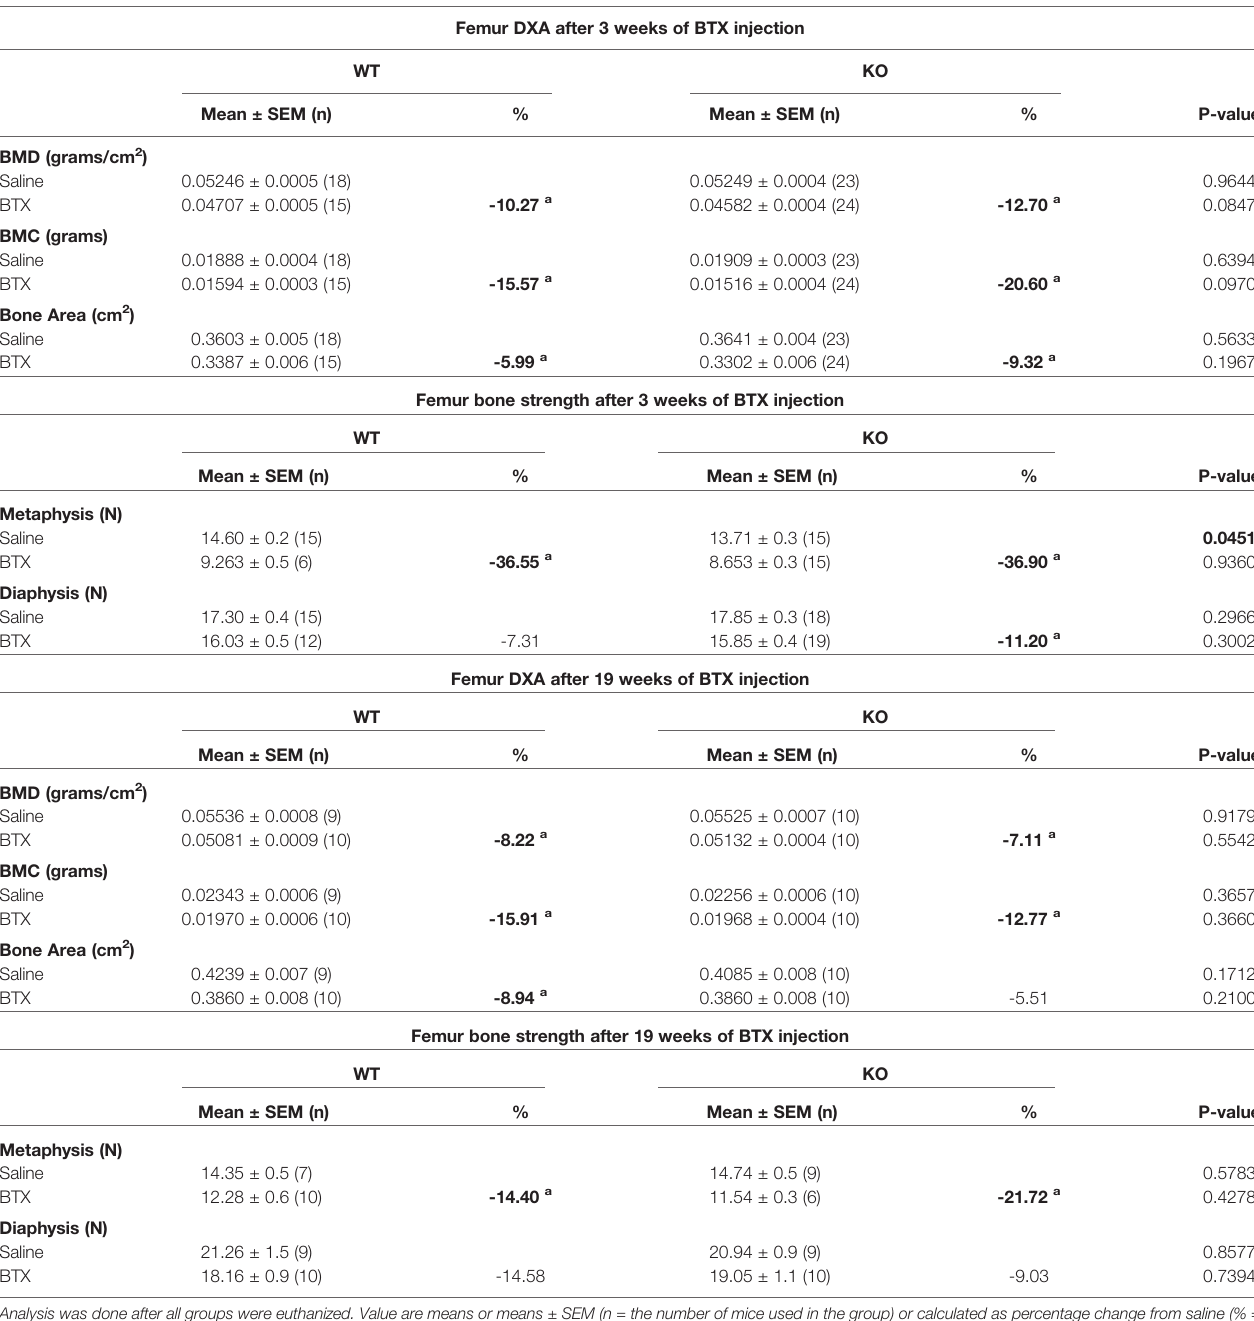
TABLE 2 | Quantitative data of femoral DXA and bone strength parameters in WT and KO mice injected with saline or BTX. Femur DXA after 3 weeks of BTX